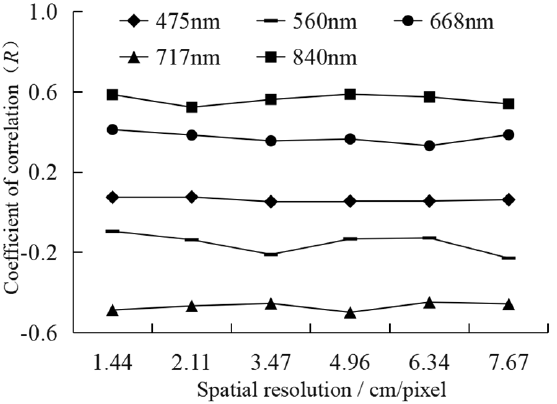
Figure 5. Correlation between reflectance and DI of each spatial resolution image band. A monitoring model’s accuracy will be impacted by information redundancy, increased calculation, challenges with data processing, and redundant information. VIs with a significant correlation to scab ( p < 0.01) and R > 0.7 were chosen to increase data processing effectiveness. Table 3 shows that the requirements are met by PSRI, RGR, SIPI, ARI, and GLI. Because the correlation coefficient has positive and negative differences, the determination coefficient is used for comparison instead of the correlation coefficient. Only the top 5 VIs with the strongest correlation to scab are analyzed for each spatial resolution image, and a vegetation index correlation diagram with five different spatial resolutions is